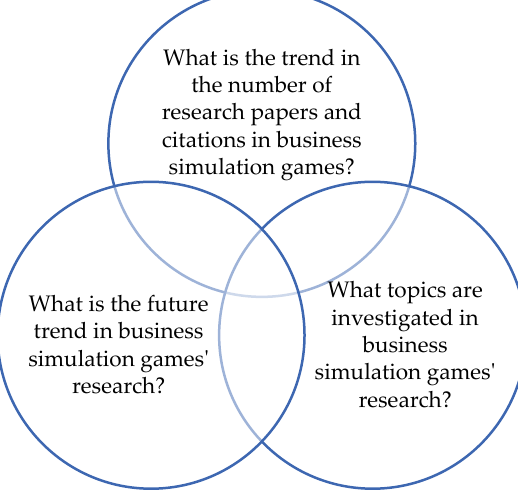
Figure 1. Research questions; Source: Authors’ work.